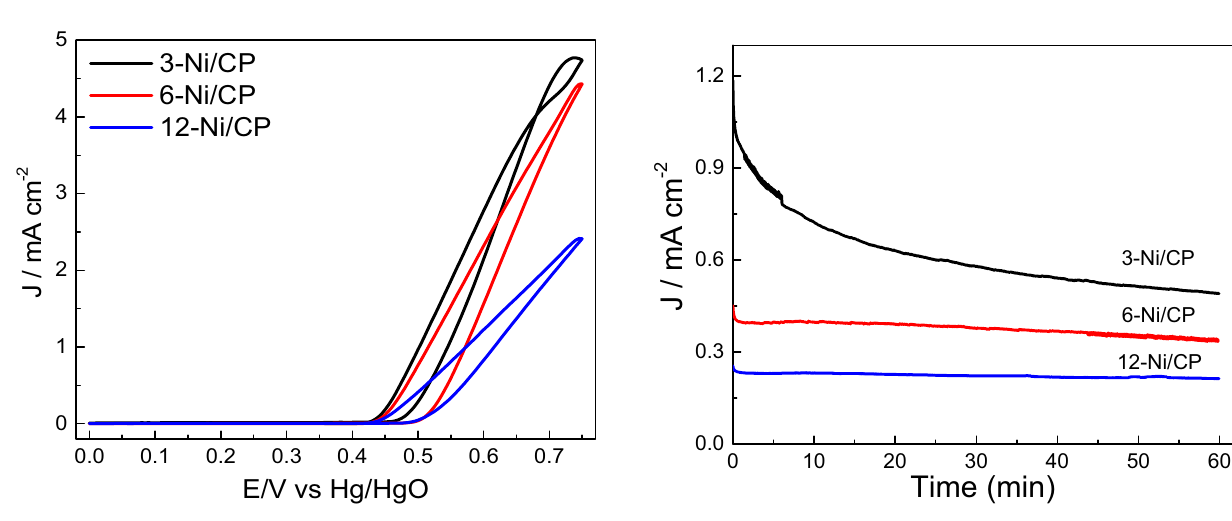
Fig. 9 Chronoamperometric measurements at 0.55 V vs Hg/HgO on 3-Ni/CP, 6-Ni/CP and 12-Ni/CP electrocatalysts in 1 mol L −1 KOH + 0.33 mol L −1